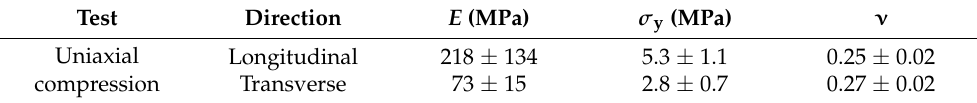
Table 1. Characteristic mechanical values of porcine trabecular bone in both orthogonal